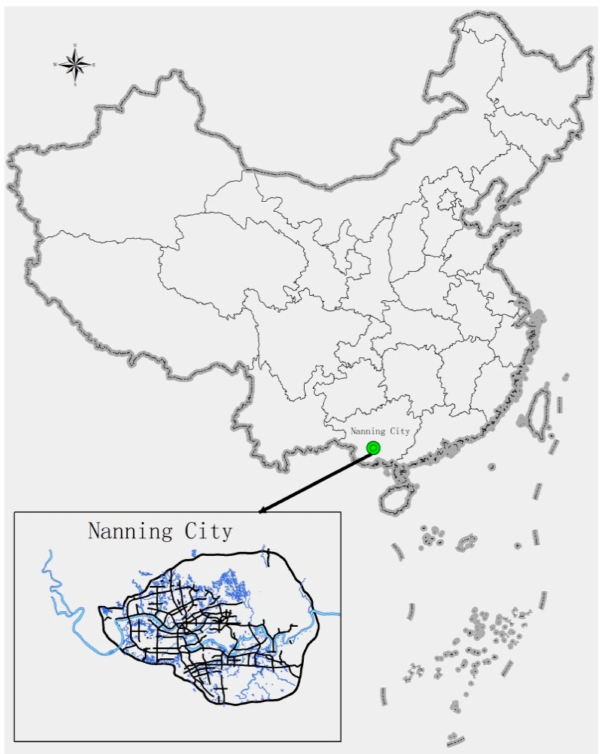
Figure 3. Location of Nanning city,